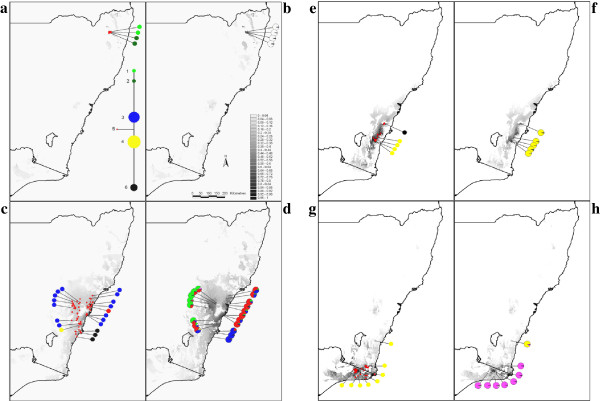
Modelled bio-climatic distribution of four Telopea species (LGM and current) and measured population-level diversity (chloroplast and nuclear). Maxent modeled bio-climatic distribution for each Telopea species for the LGM (21 ka) and current (pre-industrial) time frames (showing only model run 3b being all records projected only onto soils suitable for Telopea), showing population-level nSSR and cpSSR (colour-coded haplotypes) data for each of the sampled populations. The nSSR pie charts partition mean individual-level assignment value to a species (based on the Bayesian clustering approach implemented in STRUCTURE, at K = 6). The chloroplast network is shown in (a), and the model probability (likelihood occurrence of suitable habitat) is in a gray scale from 0 (absent) to1 (certain presence) in (b). a) T. aspera, LGM habitat and cpSSR; b) T. aspera, current habitat and nSSR; c) T. speciosissima, LGM habitat and cpSSR; d) T. speciosissima, current habitat and nSSR; e) T. mongaensis, LGM habitat and cpSSR; f) T. mongaensis, current habitat and nSSR; g) T. oreades, LGM habitat and cpSSR; h) T. oreades, current habitat and nSSR.